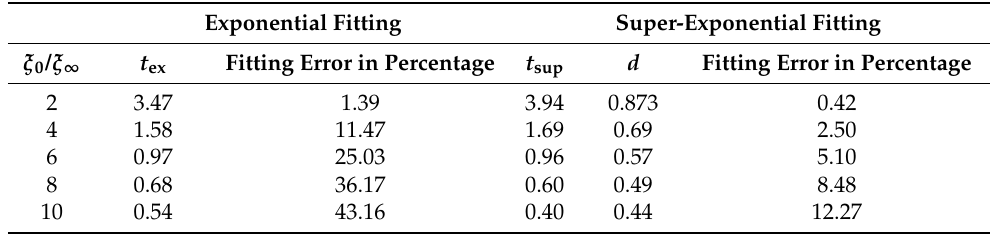
Table 1. Best-fitting damping times t ex and t sup in the exponential and super-exponential damping models, respectively, and the the super-exponential index d for different normalised initial amplitudes ξ 0 / ξ ∞ , and the respective fitting errors for the solutions to the Rayleigh oscillator equation with α = 1.2, δ − δ v = − 0.1, Ω K = 2 π